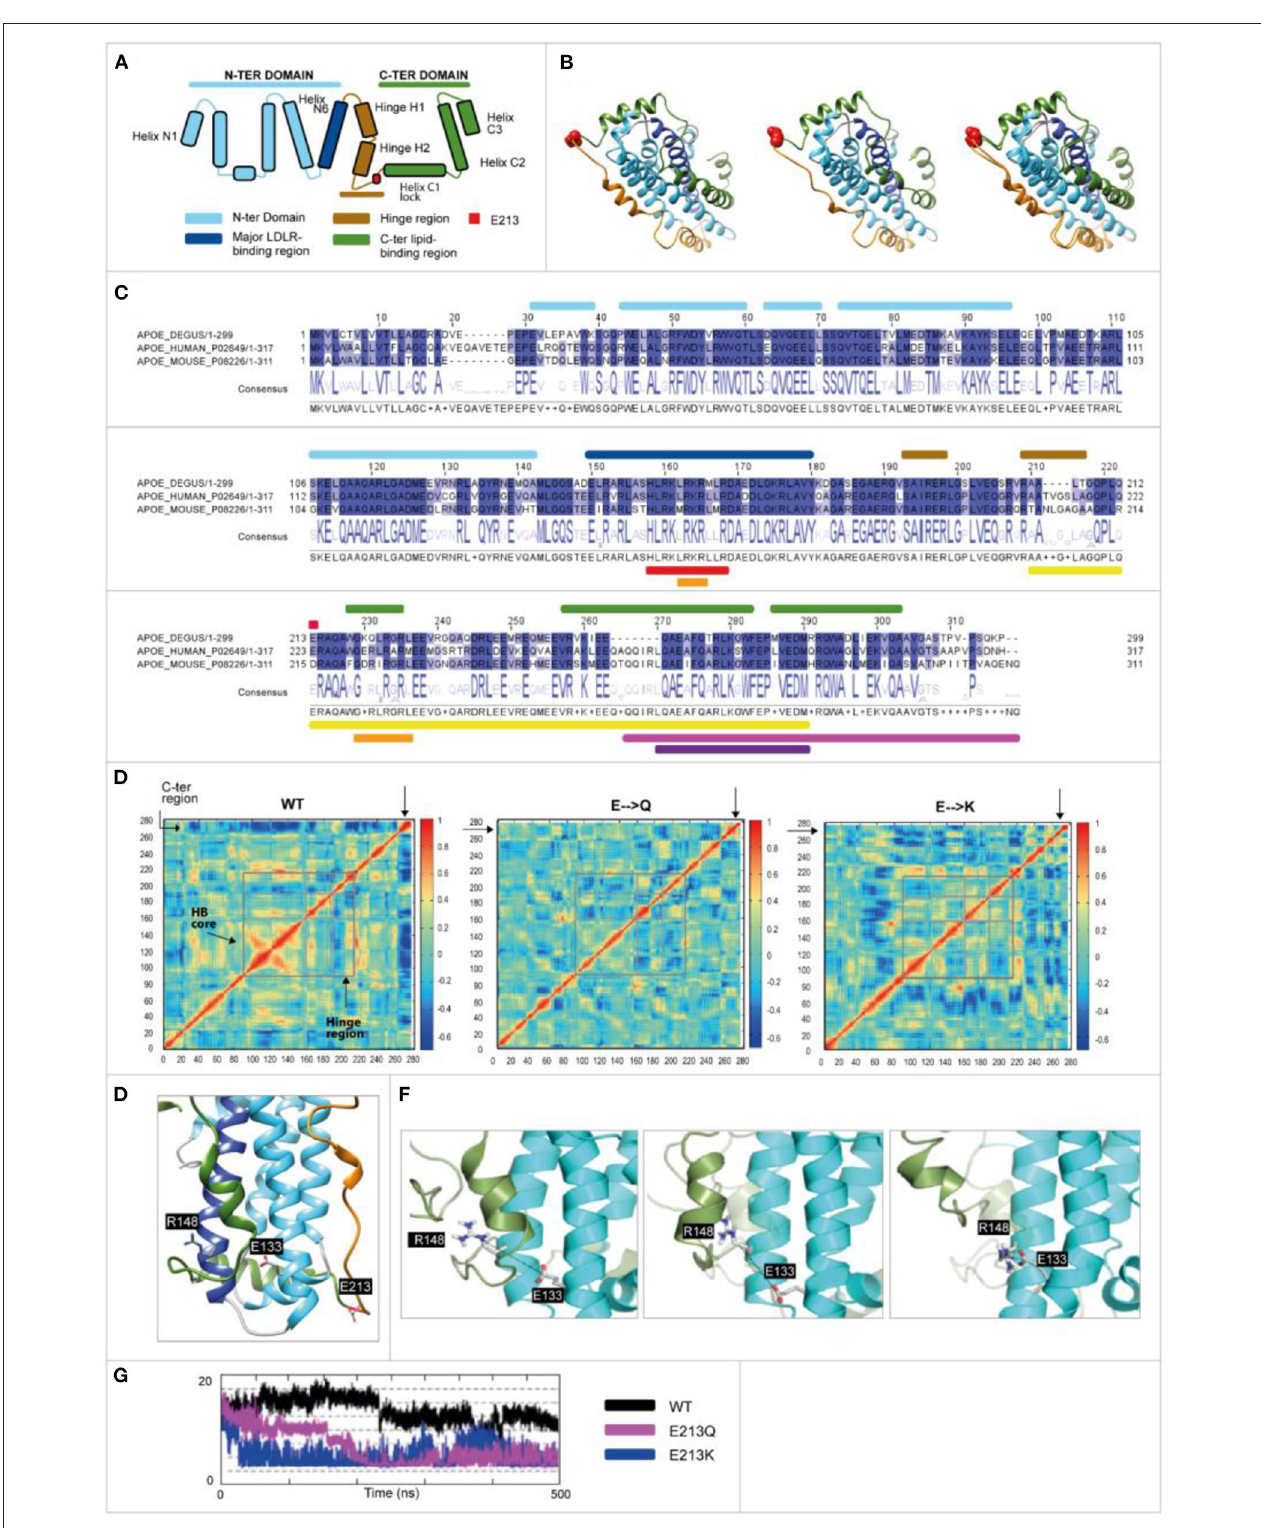
FIGURE 6 | Human and odAPOE isoforms. (A) Secondary structural scheme of APOE based on the high-resolution structure of APOE3. (B) From left to right: ribbon representation of the APOE 3 structure (UniProt code: P02649; PDB code: 2L7B), od Apoe wild-type model, and APOE 3 -degu APOE superposition that are colored as shown in the scheme. Degu E213 and human E223 are shown as red spheres. (C) Degu, human, and mouse sequence alignment. Upper bars: secondary structure